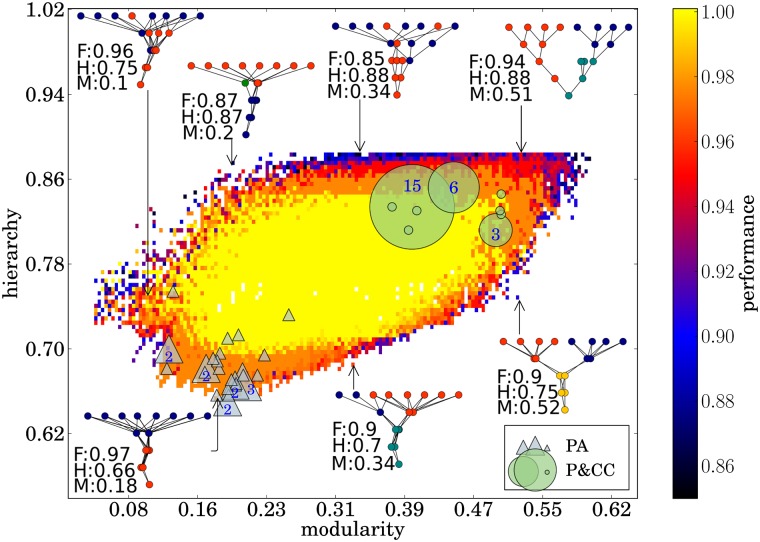
Network modularity and hierarchy can independently vary, and high-performing networks exist with a wide range of modularity and hierarchy scores.The highest-performing networks evolution discovered (with the MAP-Elites algorithm) for each combination of modularity and hierarchy. A few example networks are shown, along with their fitness (F), hierarchy (H), and modularity (M). The best network from each of the PA and P&CC treatments are also overlaid as blue triangles and green circles, respectively. The size of the circles or triangles and the enclosed number indicate the number of networks at that coordinate (no number means 1).